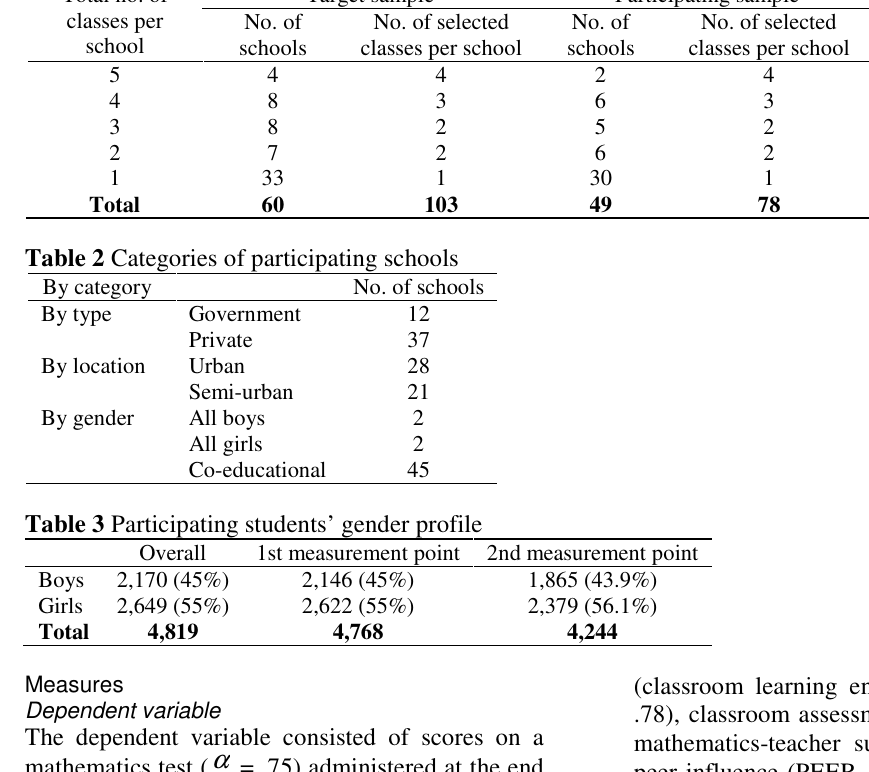
Table 1 Number of schools and sampled classes in target and participating sample Total no. of